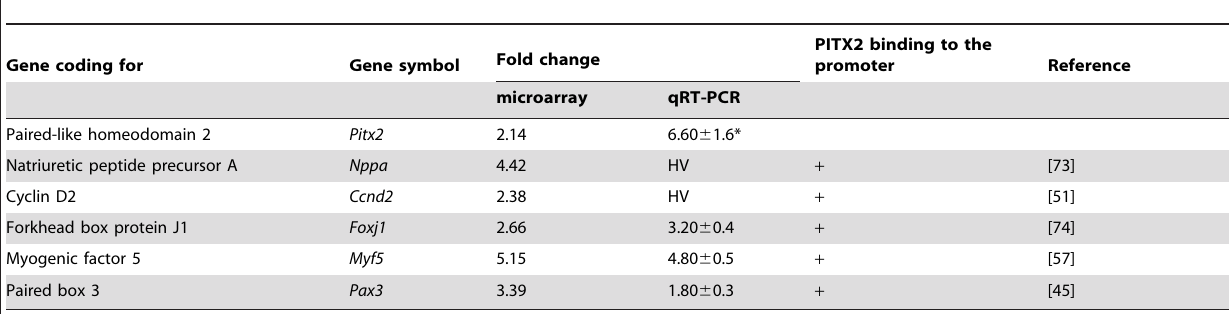
Table 1. Upregulation of genes sensitive to Pitx2 dosage in the piglet DHF model.